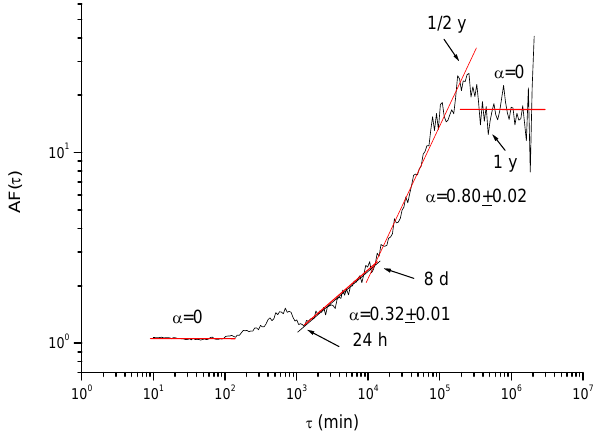
Fig. 5. AF for different elevation Figure 5. AF for different elevation thresholds.